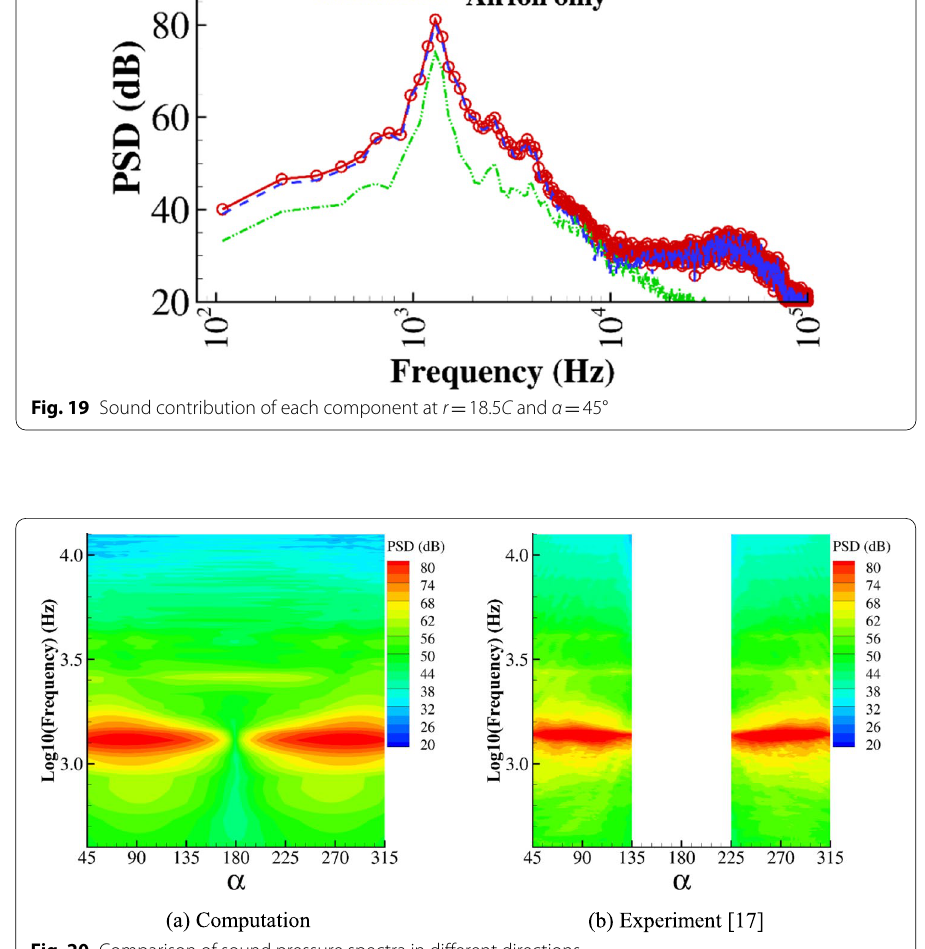
Fig. 20 Comparison of sound pressure spectra in different